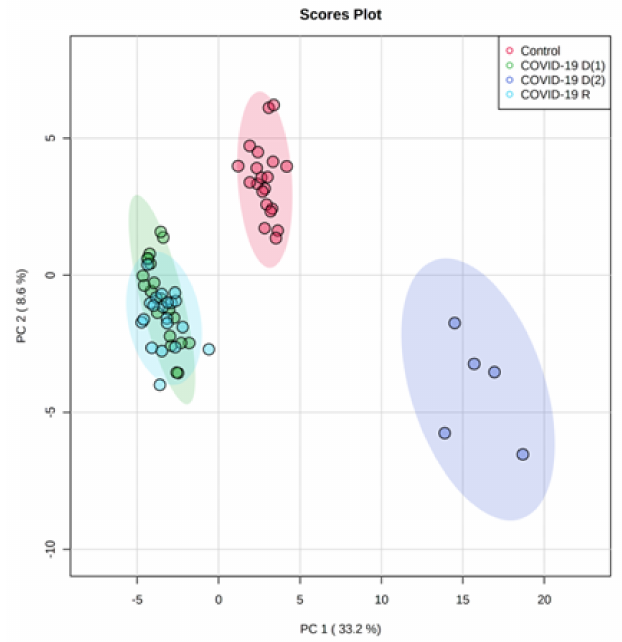
Figure 2. Two-dimensional principal component analysis (2D PCA) scores plot of the relative phospholipid content in the plasma of healthy subjects ( n = 20) [Control] , first subgroup of deceased COVID-19 patients ( n = 15) [COVID-19 D(1)] , second subgroup of deceased COVID patients ( n = 5) [COVID-19 D(2)] and COVID-19 recovered patients ( n = 20) [COVID-19 R] .